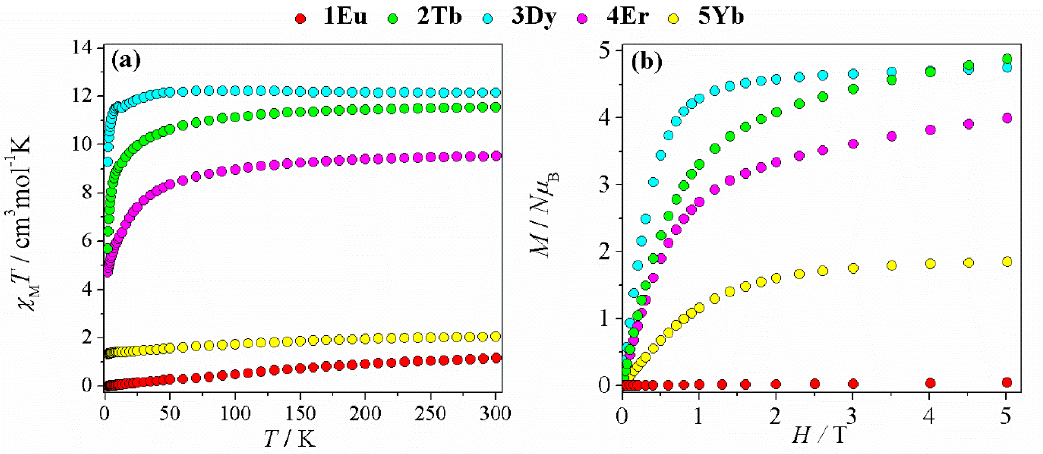
Figure 5. Plots of ( a ) χ M T vs. T, ( b ) field dependence of the magnetization plots for 1Eu – 5Yb . At 300 K, the χ M T values for compounds 1Eu – 5Yb are 1.16, 11.55, 12.15, 9.52, and 2.05 cm 3 mol − 1 K, respectively. These data are in good agreement with the expected room temperature values for the corresponding Ln(III) centers [53]. In the case of the 1Eu compound, the non-zero value of χ M T reveals the presence of excited states that are very close in energy to the fundamental one [54]. For compounds 2Tb and 4Er, the χ M T values remain practically constant as the samples are cooled to T ≈ 150 K. Below this temperature, the susceptibilities gradually decrease to values of χ M T = 9.12 cm 3 mol − 1 K a T = 11 K for 2Tb and χ M T = 7.68 cm 3 mol − 1 K a T = 30 K for 4Er . From these temperatures, the fall of the χ M T values accelerates to reach minimum values equal to 5.69 cm 3 mol − 1 K for 2Tb and 4.70 cm 3 mol − 1 K for 4Er at T = 2 K. For the 3Dy complex, it is observed that the χ M T values are practically constant when decreasing the temperature. From T = 8 K, the χ M T values de- crease quickly to χ M T = 9.28 cm 3 mol − 1 K at 2 K. Magnetization measurements at 2 K were also performed for complexes 1Eu – 5Yb and are depicted in Figure 5b. The magnetization saturation under an applied field of 5T is only observed in compounds 3Dy and 5Yb , with M values equal to 4.75 and 1.85 Nµ B , respectively. 2.2.2. ac Magnetic Studies Magnetic susceptibility measurements were performed on compounds 2Tb – 5Yb at a 4 G ac field oscillating between 10 and 1488 Hz. Under zero dc magnetic field, no maxima for the in-phase ( χ M ’) and out-of-phase ( χ M ”) susceptibility components were observed for any of the compounds, which was probably due to an important quantum tunneling of the magnetization (QTM) process present in these systems. To suppress the QTM relaxa- tion process, an optimal external dc field of 1000G was applied for the complexes 2Tb – 5Yb after checking with low fields and basing on recent works reported by the authors [41–43]. Then, slow relaxation of the magnetization was revealed (Figure 6 and Support- ing Information, Figure S2) for the compounds 3Dy – 5Yb [55,56].